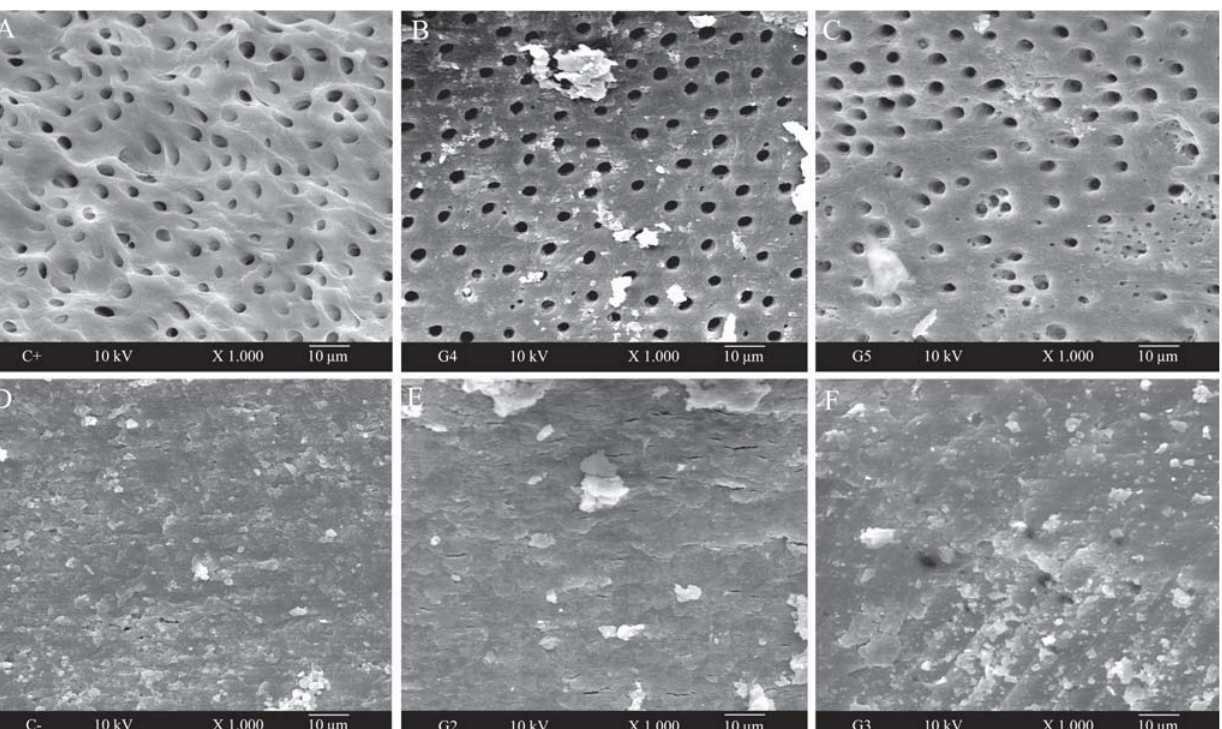
Different letters indicate statistically significant difference (p<0.01; Kruskall Wallis